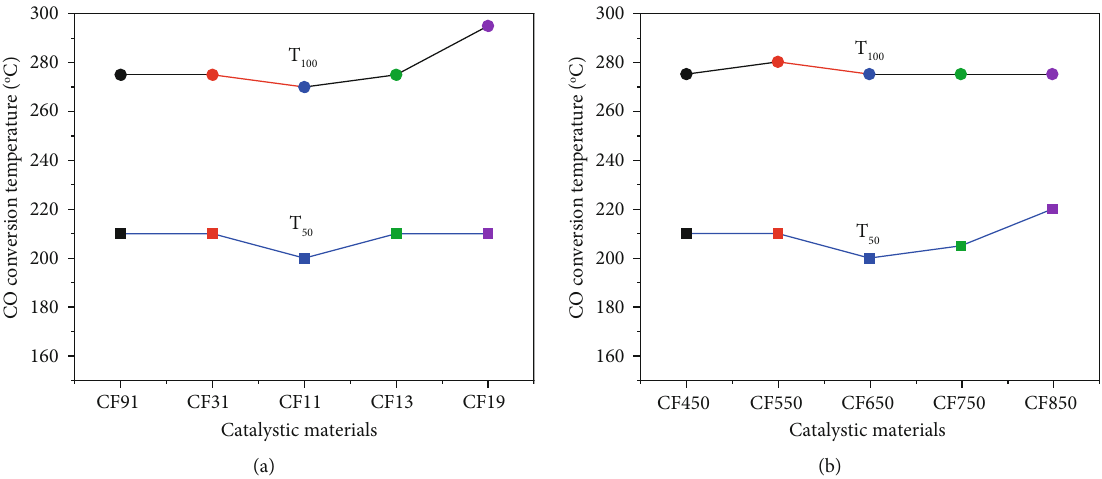
T Figure 9: T 50 and 100 temperatures of CeO 2 -Fe 2 O 3 samples. Samples with di samples calcined at di ff erent temperatures for 2 h